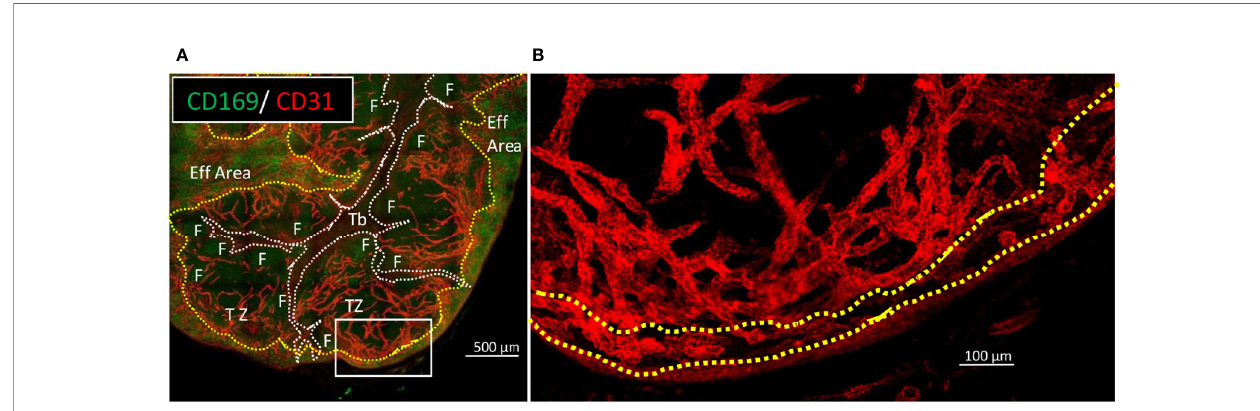
FIGURE 5 | Blood vessels are evenly distributed from B cell follicles neighborhood to the inside of the efferent area. Thick sections of tracheobronchial LN have been cleared with iDISCO+ and stained for CD169 (green) and CD31 (red). (A) wide view of CD169 (green) and CD31 (red) staining in order to delimit trabeculae (doted white lines) and efferent area (dashed yellow lines). F, Follicle; Tb, Trabeculae; TZ, T cell zone; Eff Area, efferent area. (B) Close up the white rectangle from (A) , with depicture of CD31 (red) staining only. Images were acquired with confocal microscope LSM780. (A) , Scale bar 500µm. (B) , scale bar 100µm Images are representative of 2 LN from one